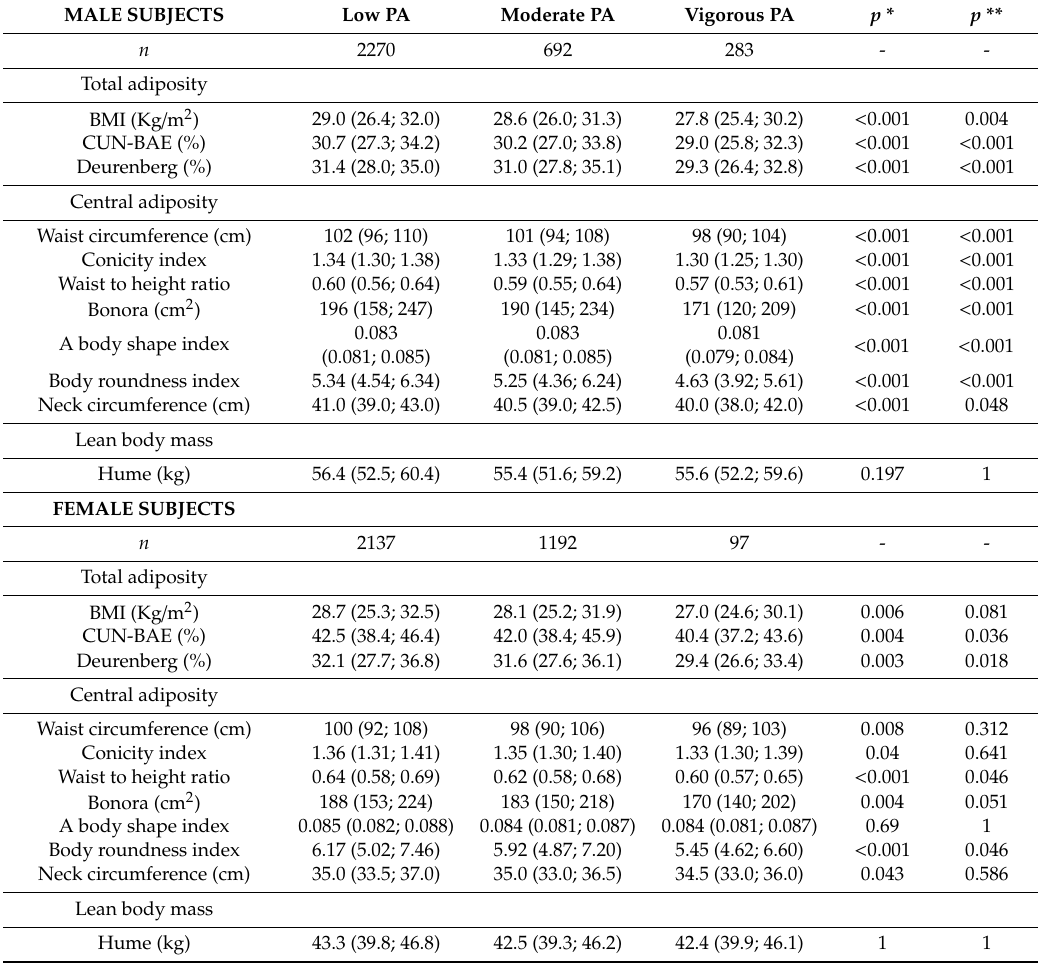
Table 3. Obesity indices in male and female participants according to their physical activity practice.